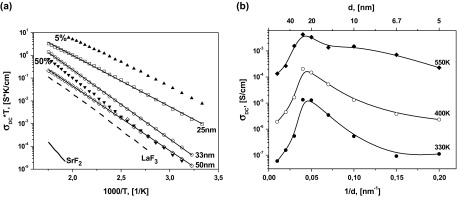
(a) Temperature dependencies of longitudinal conductivity of SrF2 (solid lines) and LaF3 films (dashed lines) heterostructures with d = 25, 33, and 50 nm (open squares, circles, and rhombuses, respectively) and films of solid solutions La1-xSrxF3-x with 5% and 50% SrF2 content (full triangles). The lines are fits to the Arrhenius–Frenkel equation. (b) The dependence of the longitudinal conductivity on 1/d at 330, 400, and 550 K.